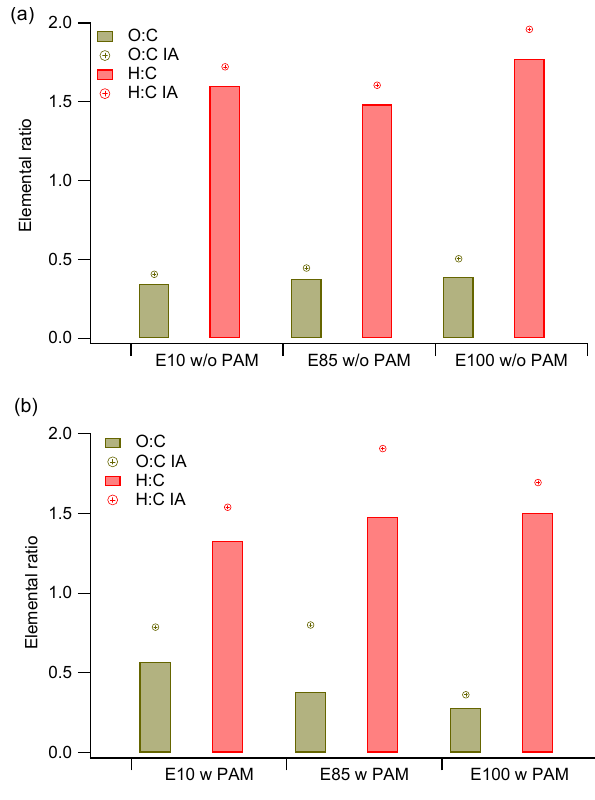
Figure 3. The average elemental composition (O:C and H:C ra- tios) of the emitted primary (a) and secondary (b) PM during the NEDC for E10, E85 and E100. The elemental composition is calcu- lated using the original method developed by Aiken et al. (2007) and using a revised method (marked with IA to indicate improved am- bient) containing the more atmospherically relevant organic com- pounds developed by Canagaratna et al.